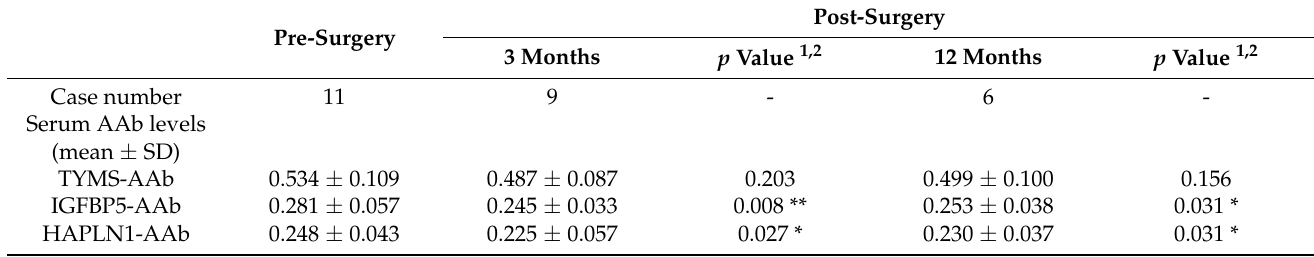
Table 2. Serum levels of CMT-associated AAbs in 11 CMT dogs before and after surgery.